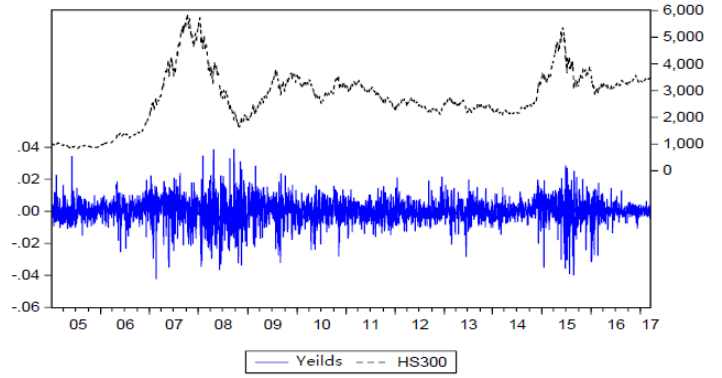
Fig. 1 Sequence Diagram of Sample Closing Price and Rate of Return.